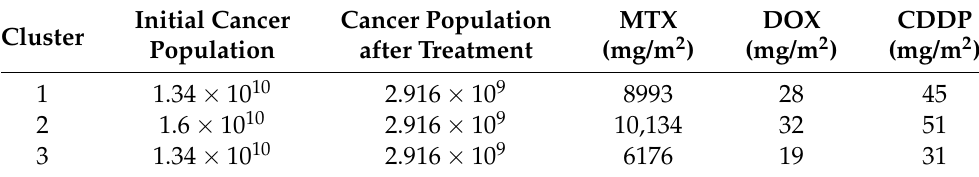
Table 5. Optimal MAP dosages for large tumors.